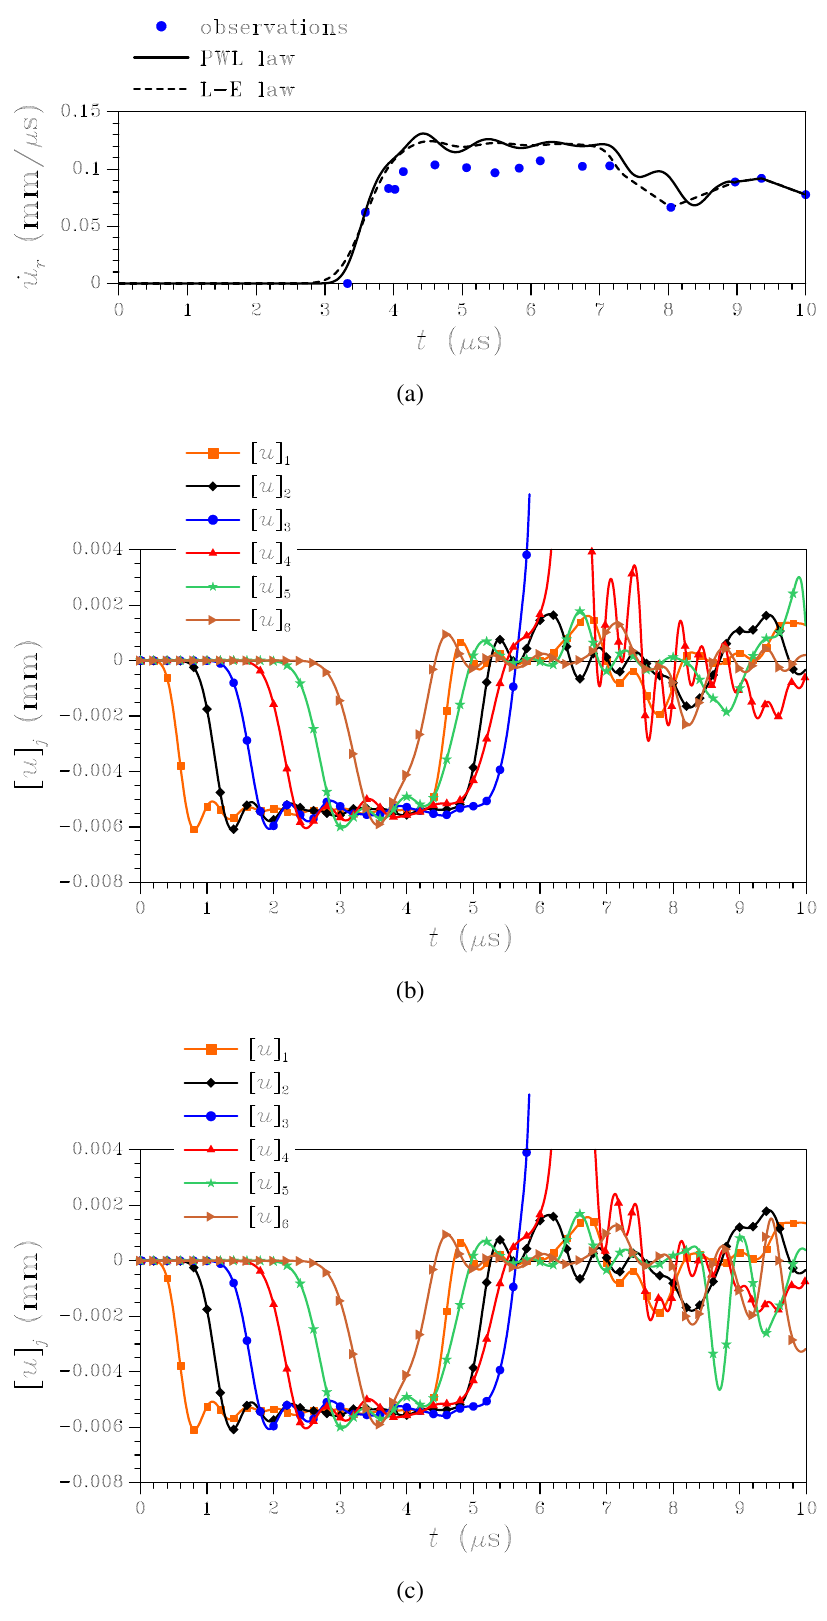
Figure 4. Impact on a 7-layer composite [13]: (a) comparison between experimental and tracked free surface velocity records; (b-c) estimated values of inter-laminar openings [ u ] j = 1 , ..., 6 (b: PWL law; c: L-E